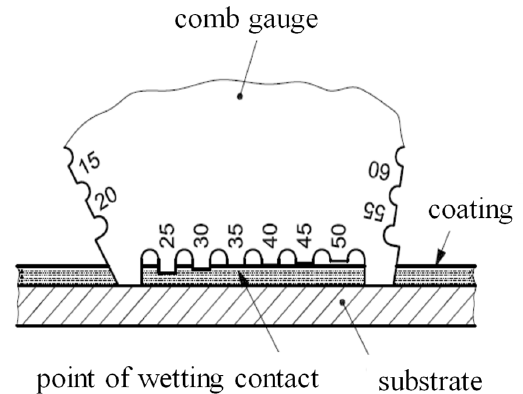
Figure 12. Exampl e of a comb gauge. Figure 12. Example of a comb